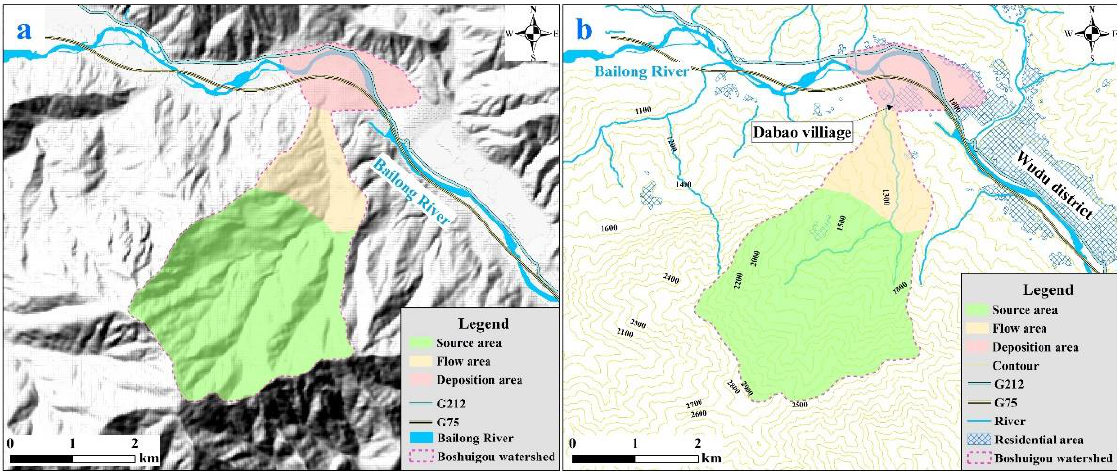
Figure 2. Panoramic ( a ) and planar view ( b ) of the Boshuigou debris flow. G212 and G75 are abbreviations of the Lanzhou – Longbang Highway and Lanzhou – Haikou Expressway, respectively.